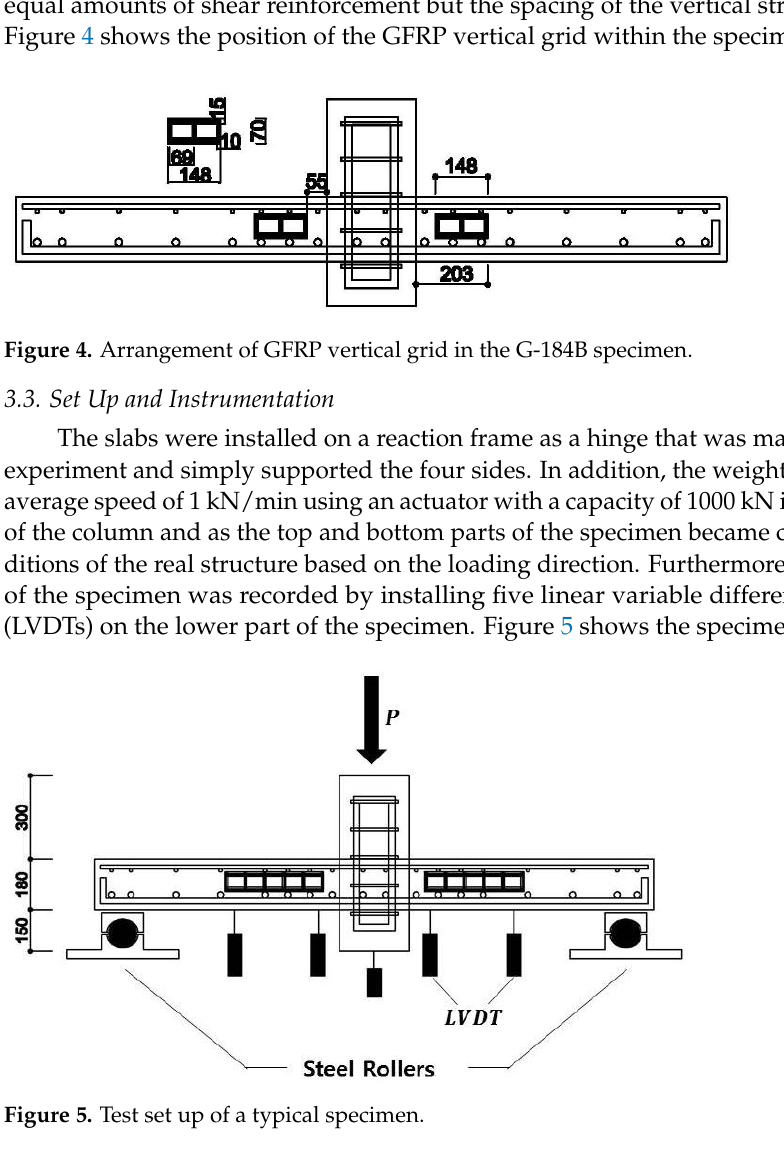
Figure 6 indicates the crack patterns of the control and the G-246B specimens and Figure 7 shows the appearance of the shear observed when a concrete cutter was applied at a spot 100 mm away from the column face of all of the specimens. Cracks started to propagate from near the column outwards along two directions on the slabs. The initial cracks of the specimen were observed in a radial shape from the side of the columns then cracks were extended from the central area as loading increased. The control specimen showed a typical punching shear failure mode in which the cracks started at the column side and developed significantly in the shape of a cone within half of the effective depth of the slab and a sudden drop was observed in the load after the maximum load. The initial crack in the specimen with the GFRP plate reinforcement was generated near the column and then cracks occurred within the critical section of the slab. As the load in- creased, the crack expanded in the slab in two directions similar to the control specimen. It was observed that the width and number of cracks expanded from the shear reinforce- ment area. In addition, the cracks developed widely toward the edges and the corners of the slabs. The G-246B specimen had larger failure areas than the control specimen (Figure 6). This indicated that the shear reinforcement produced the reinforcement effects of in- creasing the areas of the critical sections of the flat plate and that more concrete resisted the shear.